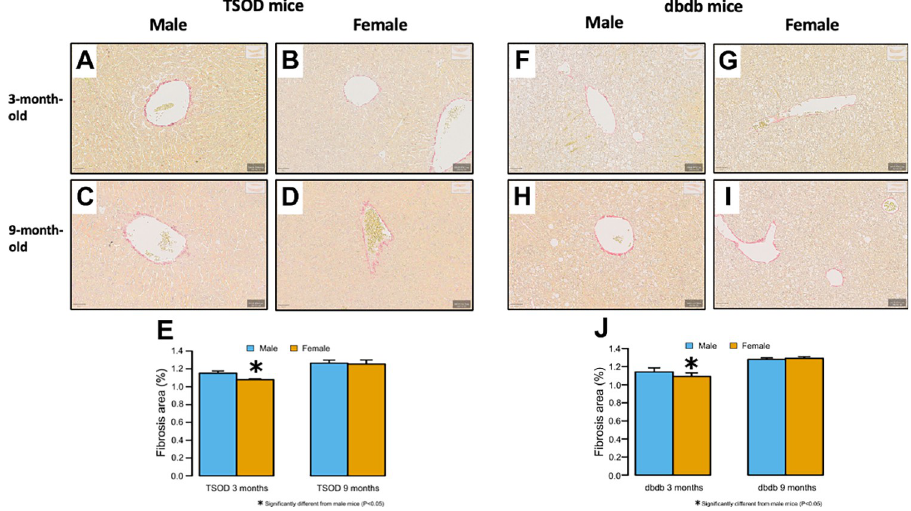
Fig 4. Image analysis for quantification of fibrosis. A-J) The frequency of Sirius red-positive fibrotic area is significantly higher in male mice than in female mice in TSOD and db/db mice at the age of 3 months (one-tailed t- test); however, significant sex differences are not observed in both strains at 9 months (two-tailed t-test). (A-D,F-I: Original magnification × 400). https://doi.org/10.1371/journal.pone.0278580.g004 were significantly higher than those in females at 3 and 9 months of age (p = 0.037 and 0.021, respectively) (Fig 6).